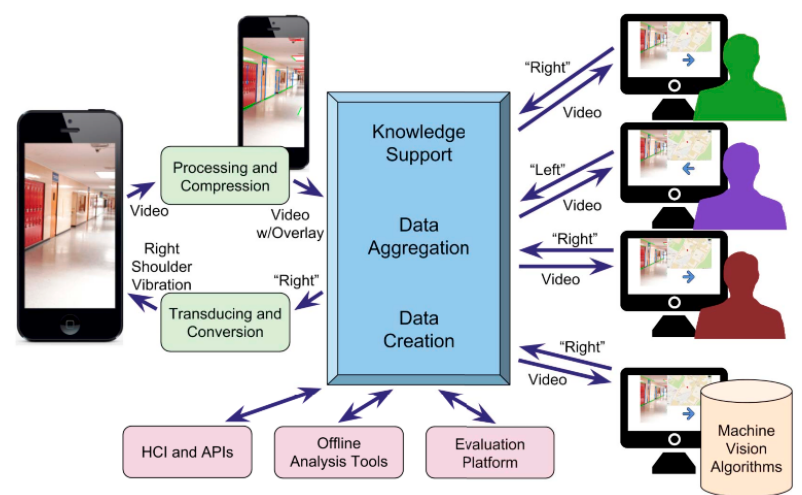
Figure 31. The proposed application’s dataflow [53].